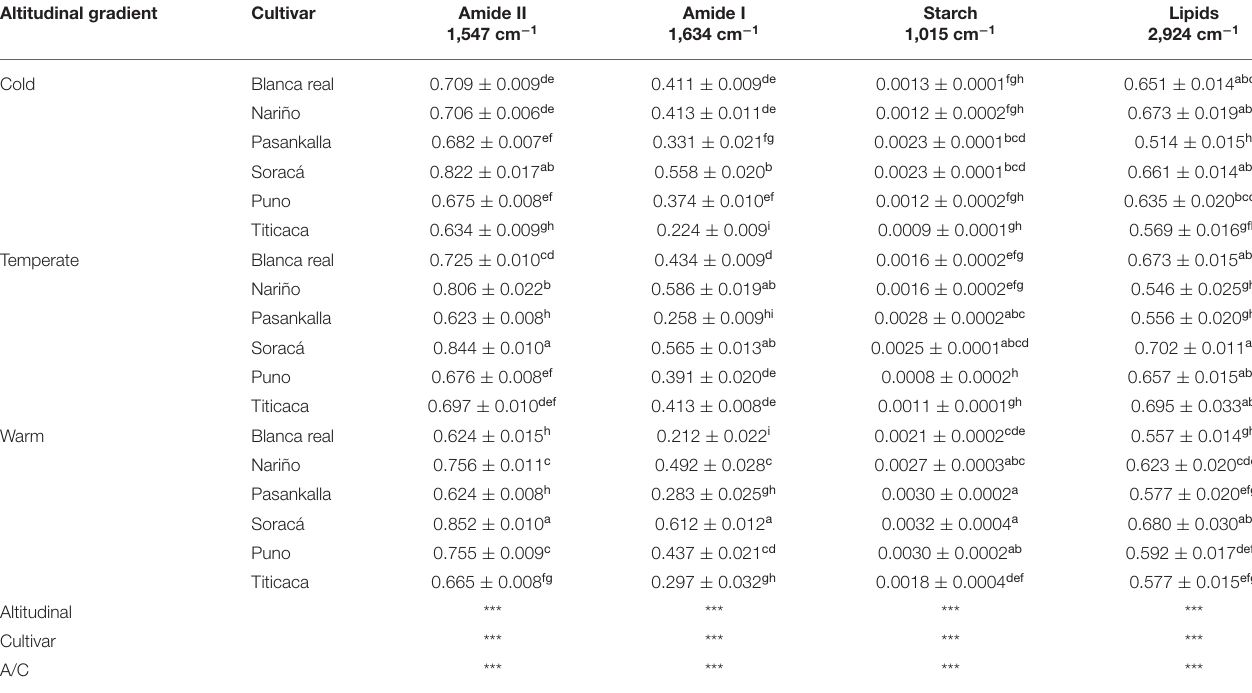
TABLE 2 | Intensity (a. u.) of bands associated with structures of interest in grains of different quinoa cultivars. Altitudinal